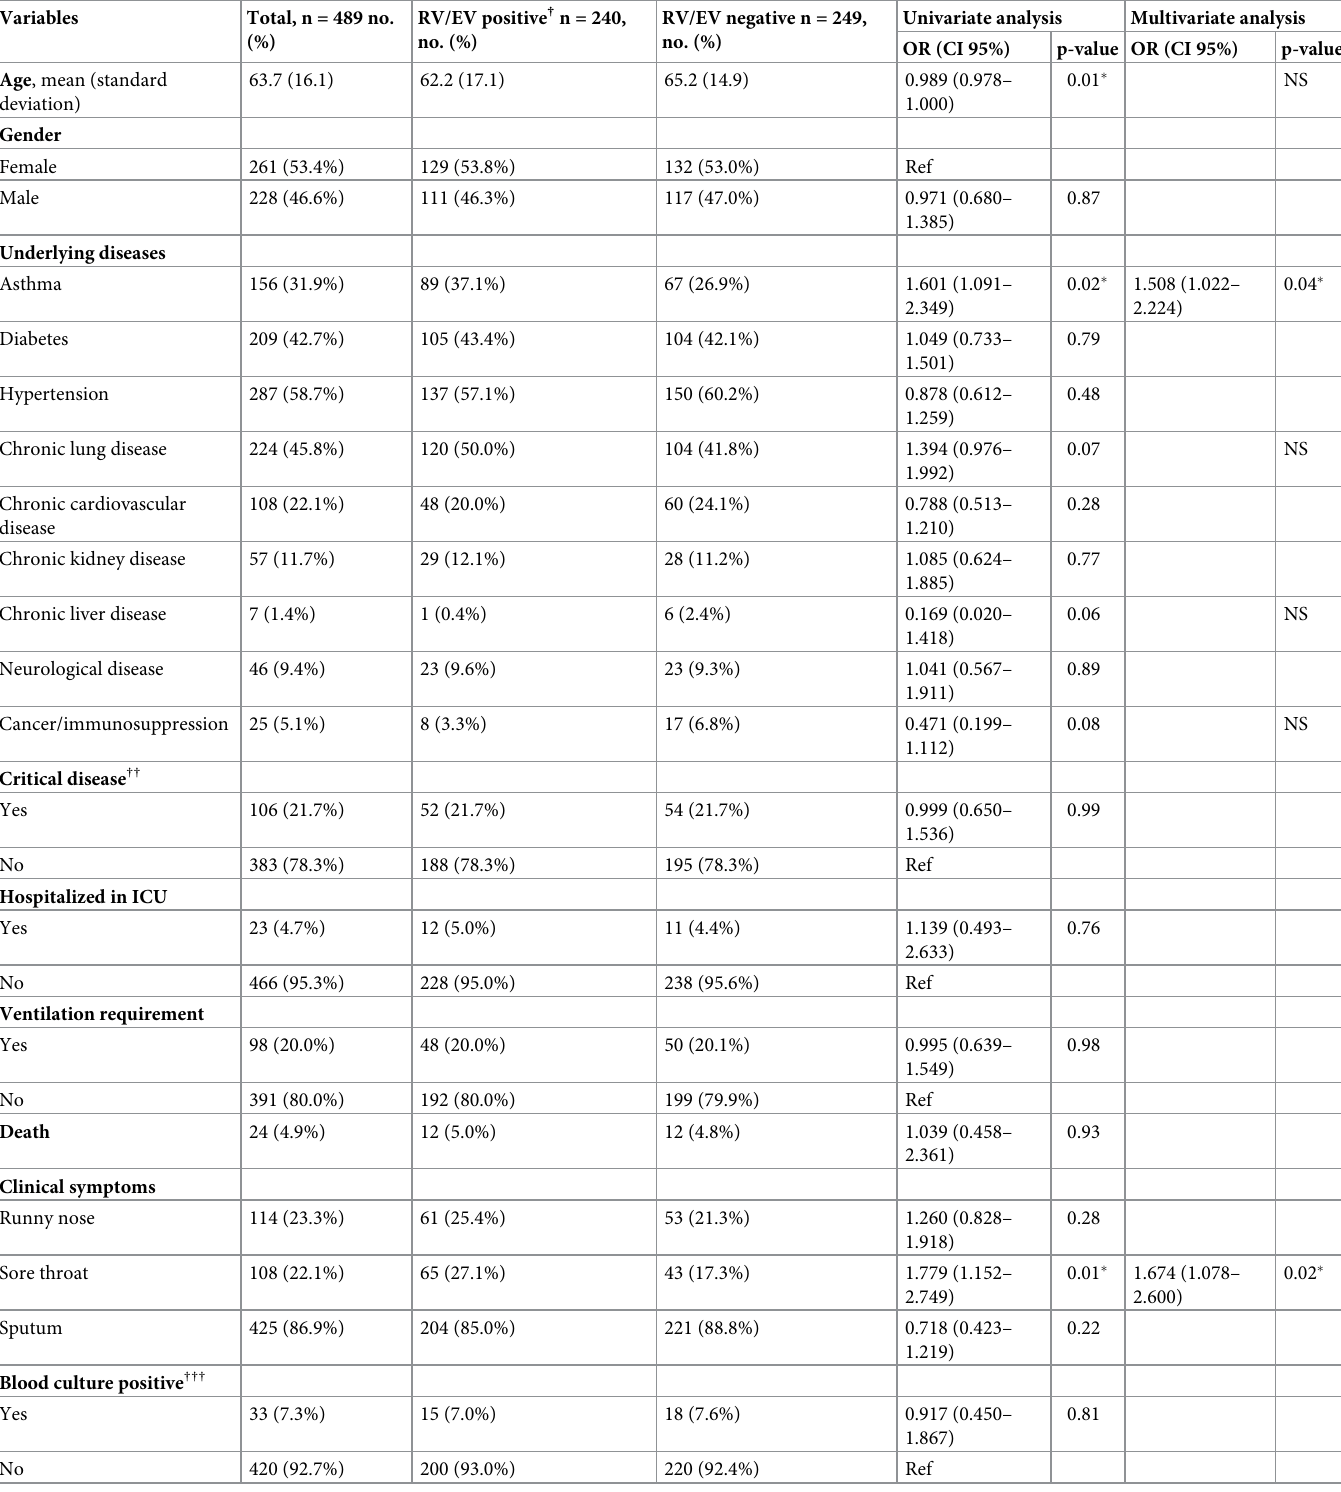
Table 4. Risk variables associated with rhinovirus/enterovirus